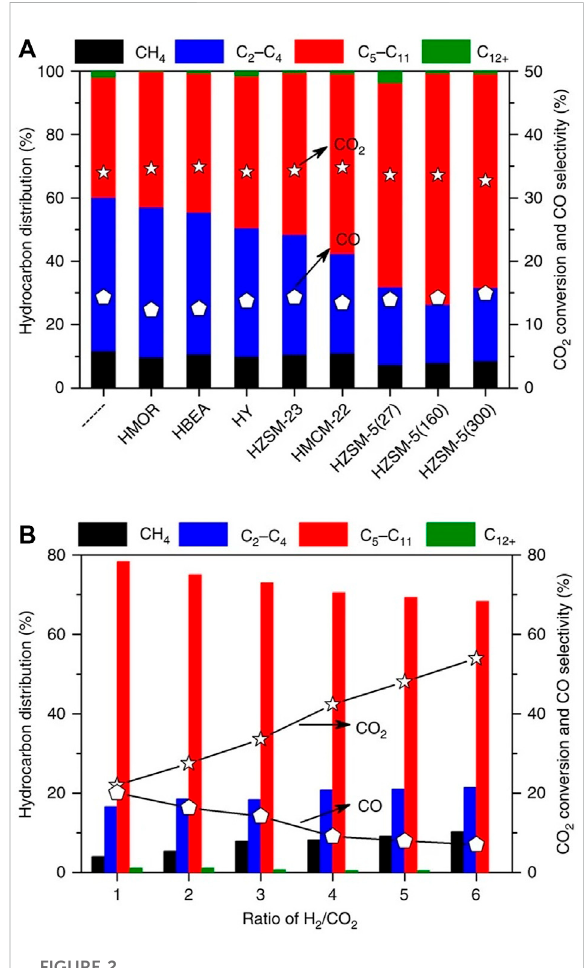
FIGURE 2 CO 2 conversion and different product selectivity of various catalysts (Wei et al., 2017). (A) Na-Fe 3 O 4 /zeolite catalysts. (B) Different H 2 /CO 2 ratios over Na-Fe3O4/HZSM-5